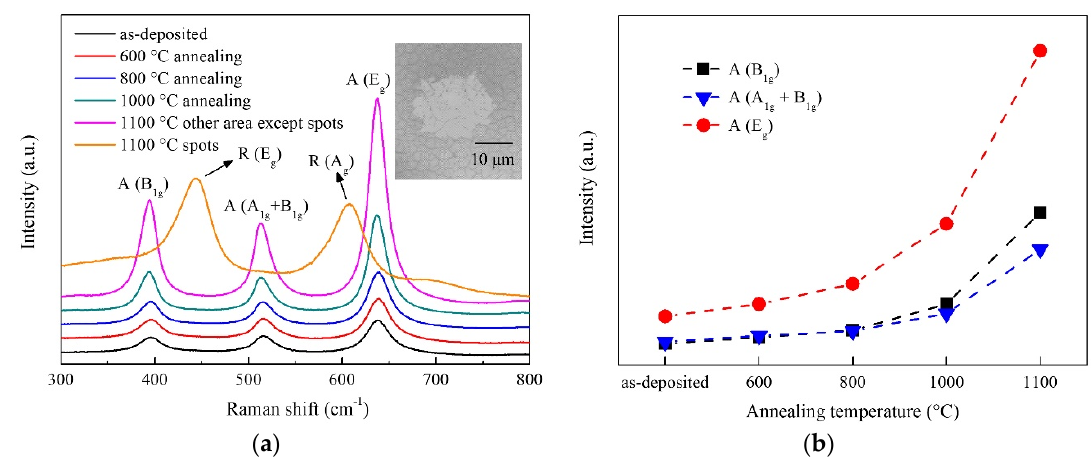
Figure 3. Raman results of as-deposited TiO 2 films and TiO 2 films after annealing. (( a ) Raman spectra of TiO 2 films; ( b ) Raman peak intensities of TiO 2 films).